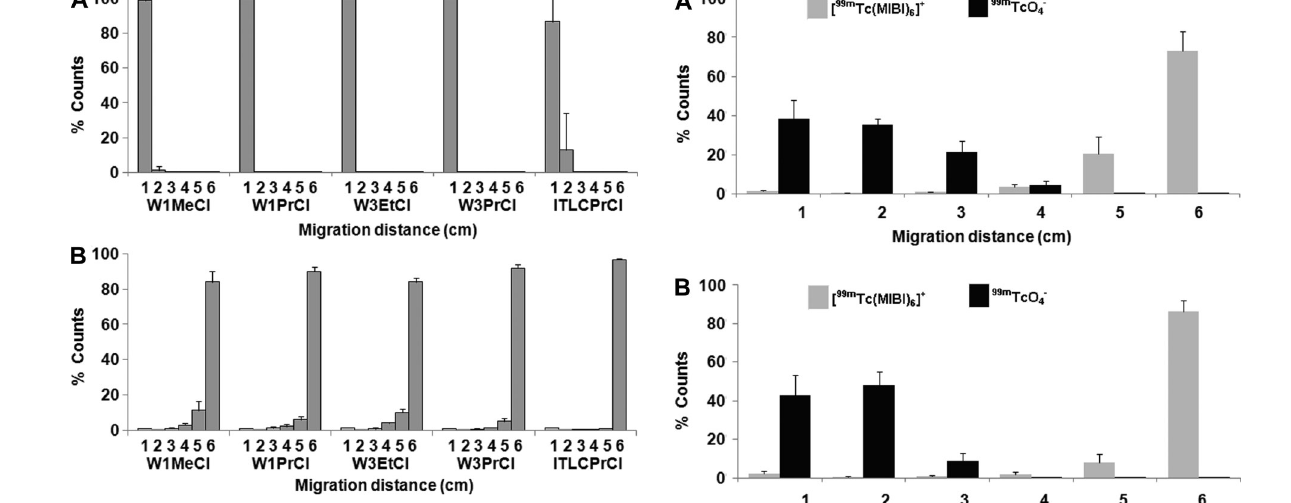
Figure 3. Chromatography of 99m TcO 4– ( A ) and [ 99m Tc(MIBI) 6 ] + ( B ) reported as percent of counts in segments of the chromato- graphic strip (cm), numbers 1 to 6. The following chromato- graphic systems were used: (W1MeCl) W1 paper/methanol: chloroform (25:75), (W3EtCl) W3 paper/ethanol:chloroform (25:75), (W1PrCl) W1 paper/propanol:chloroform (25:75), (W3PrCl) W3 paper/propanol:chloroform (25:75), and (ITLCPrCl) ITLC-SG/propanol:chloroform (25:75). Data are reported as means±SD for n=18.